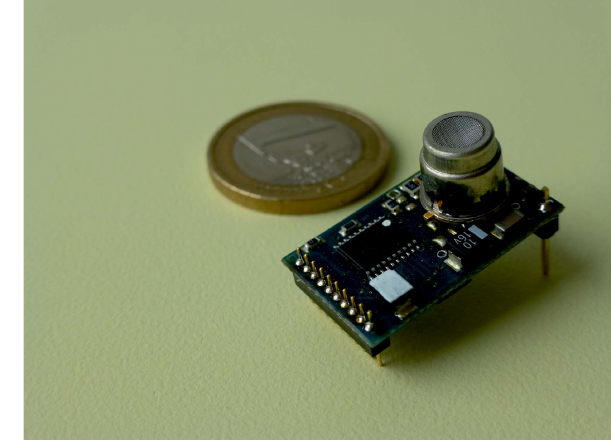
Figure 1. The VOC sensor manufactured by the former ETR-